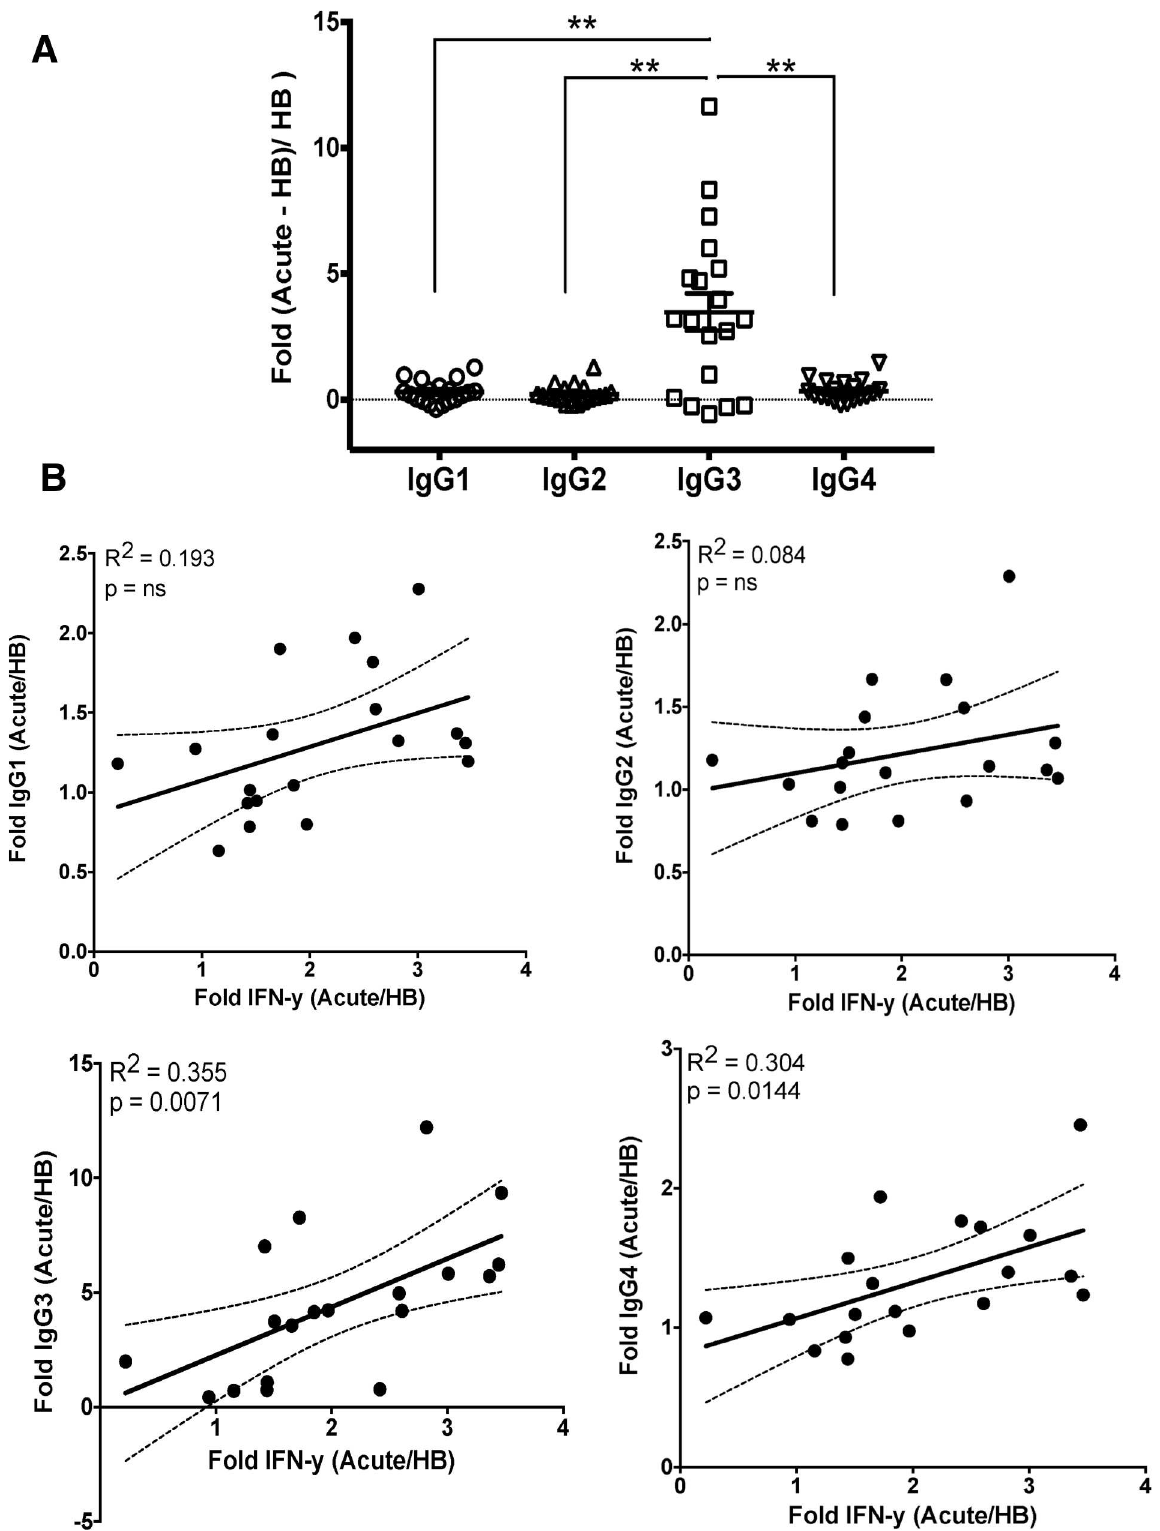
Fig 7. Change in IgG subclass levels during acute malaria and correlation with plasma IFN- γ levels. ( A ) Fold changein total plasma IgG subclasses duringacute malaria relative to pre-infection baseline(n = 19 Malian children).( B ) Fold change in total